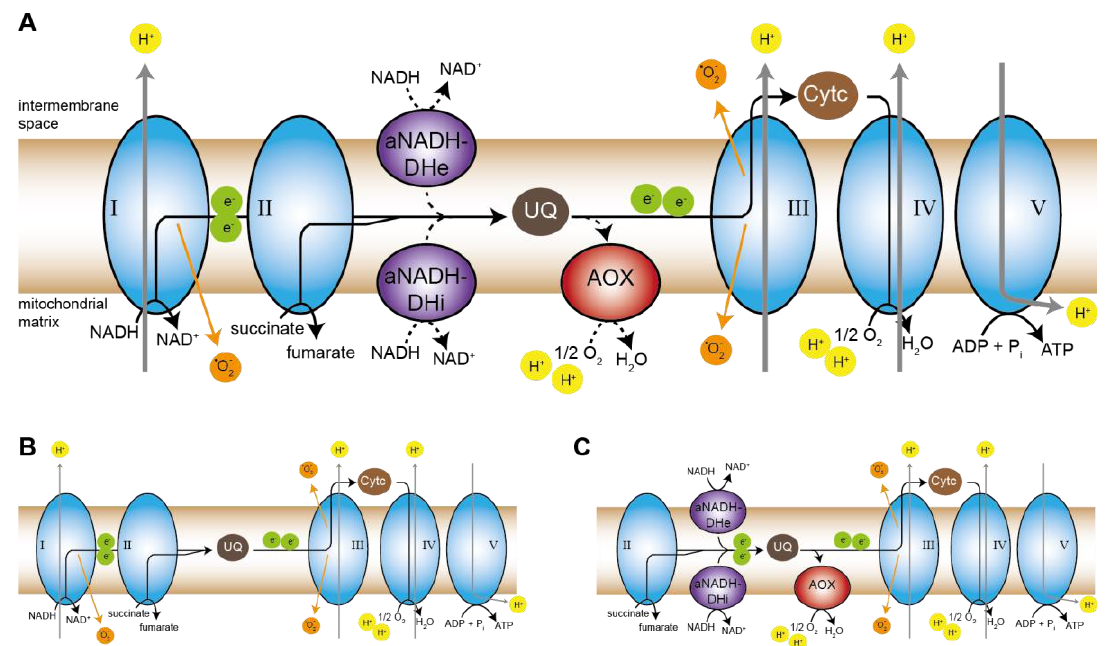
Figure 7. Model of respiration in wild type and pro34. ( A ) Overview of the fungal mitochondrial respiratory chain including alternative NADH dehydrogenases (aNADH-DH; e for external and i for internal enzymes in relation to the mitochondrial matrix) and alternative oxidase (AOX) bypasses. Main mitochondrial complexes are depicted in blue and numbered. The aNADH-DHs are shown in purple, AOX in red. Cytc, cytochrome c; UQ, ubiquinone. Electrons from NADH are introduced into the respiratory chain by either complex I or aNADH-DHs. Complexes I and III produce superoxide (orange). Proton (yellow) flux is depicted by gray arrows, electron (green) flux by black arrows. The route of electrons in the canonical pathway is shown by solid arrows, the route via alternative compo- nents is shown by dashed arrows. Note that only protons transported across the inner mitochondrial membrane and protons used for the generation of water by AOX and complex IV are depicted in the model. Modified from [67,84]. ( B ) Respiration in wild type follows the canonical route via complexes I through V. ( C ) Mutant pro34 lacks functional complex I and shows respiration via aNADH-DHs and complexes III and IV. Most probably, complex II and the rotenone-insensitive aNADH-DHs are used for the delivery of reducing equivalents and for feeding electrons to ubiquinone in the mutant. AOX may prevent the reshuffling of electrons to complex I intermediates and thereby prevent oxidative